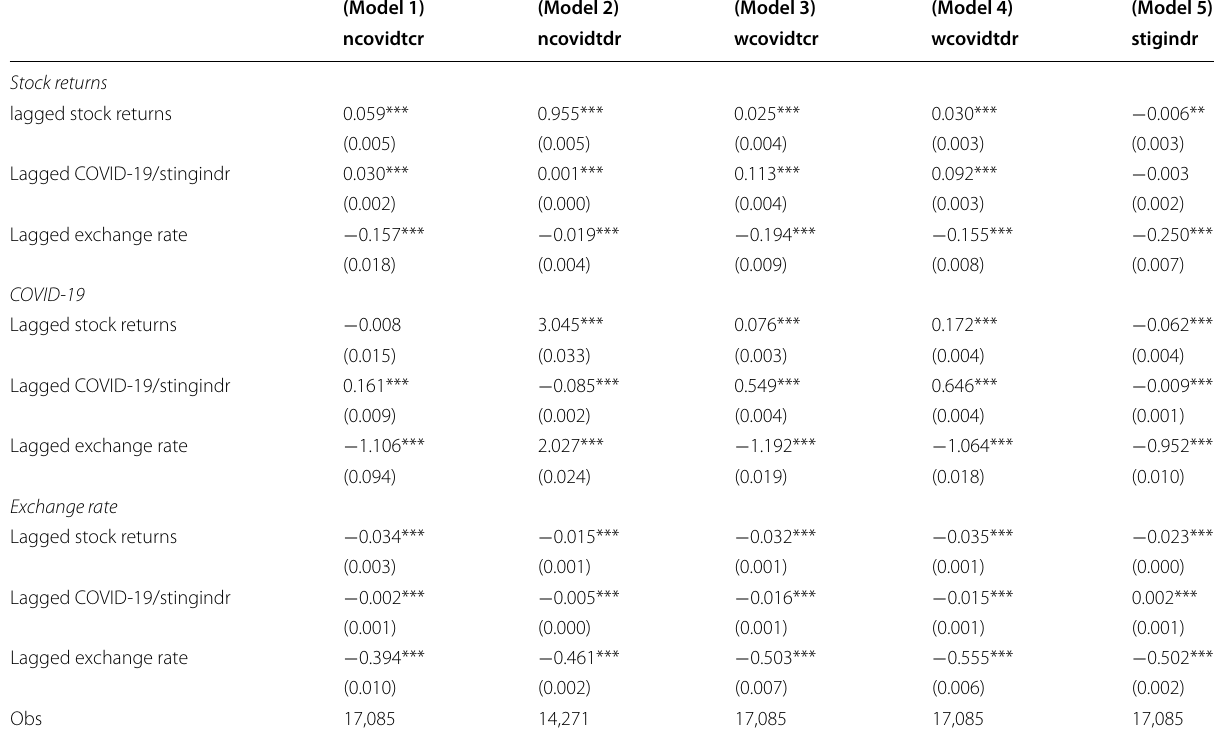
Table 7 Panel VAR